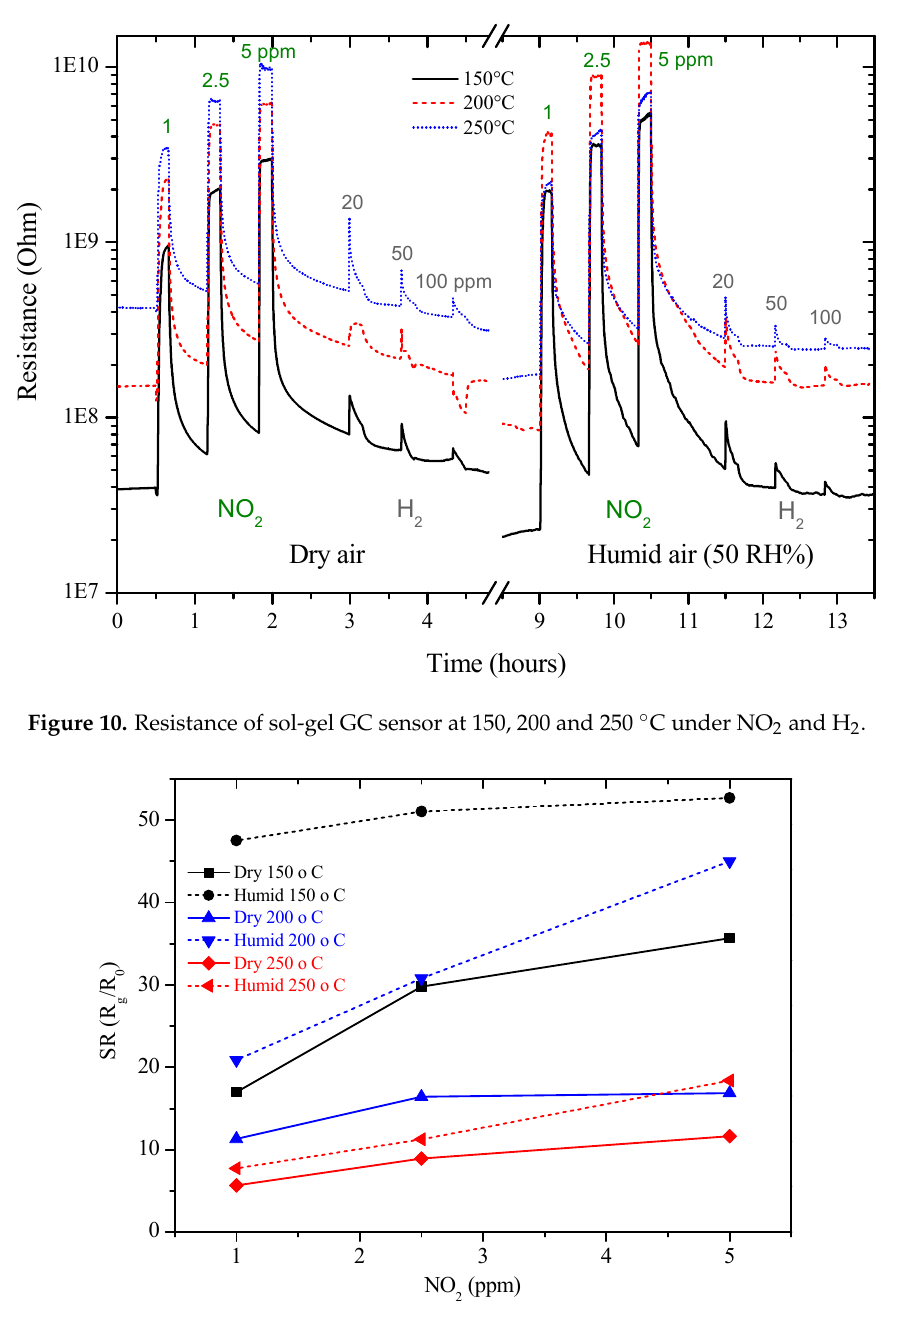
Figure 11. Sensor response of GC sol-gel sensor at 150, 200 and 250 °C under NO 2 in dry air and under 50 RH%.